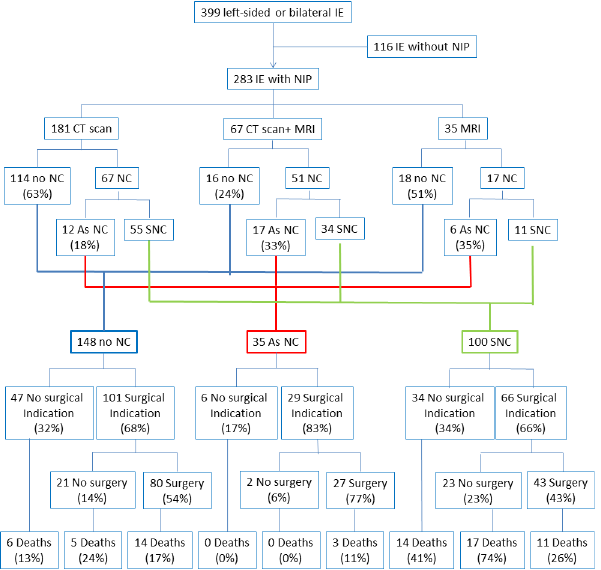
Fig 1. Patients' flow chart. IE: infective endocarditis, NIP: neuroimaging procedure, SNC: symptomatic neurological complications, AsNC: asymptomatic neurological complications, NoNC: no neurological